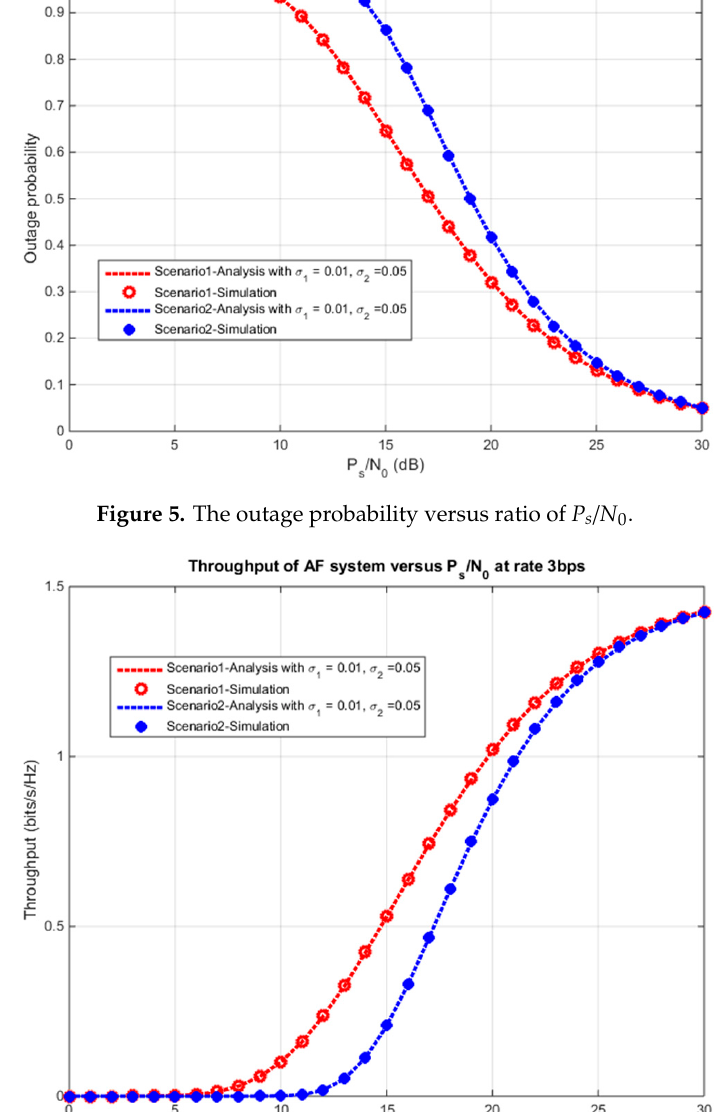
Figure 6. The throughput versus ratio P s / N 0